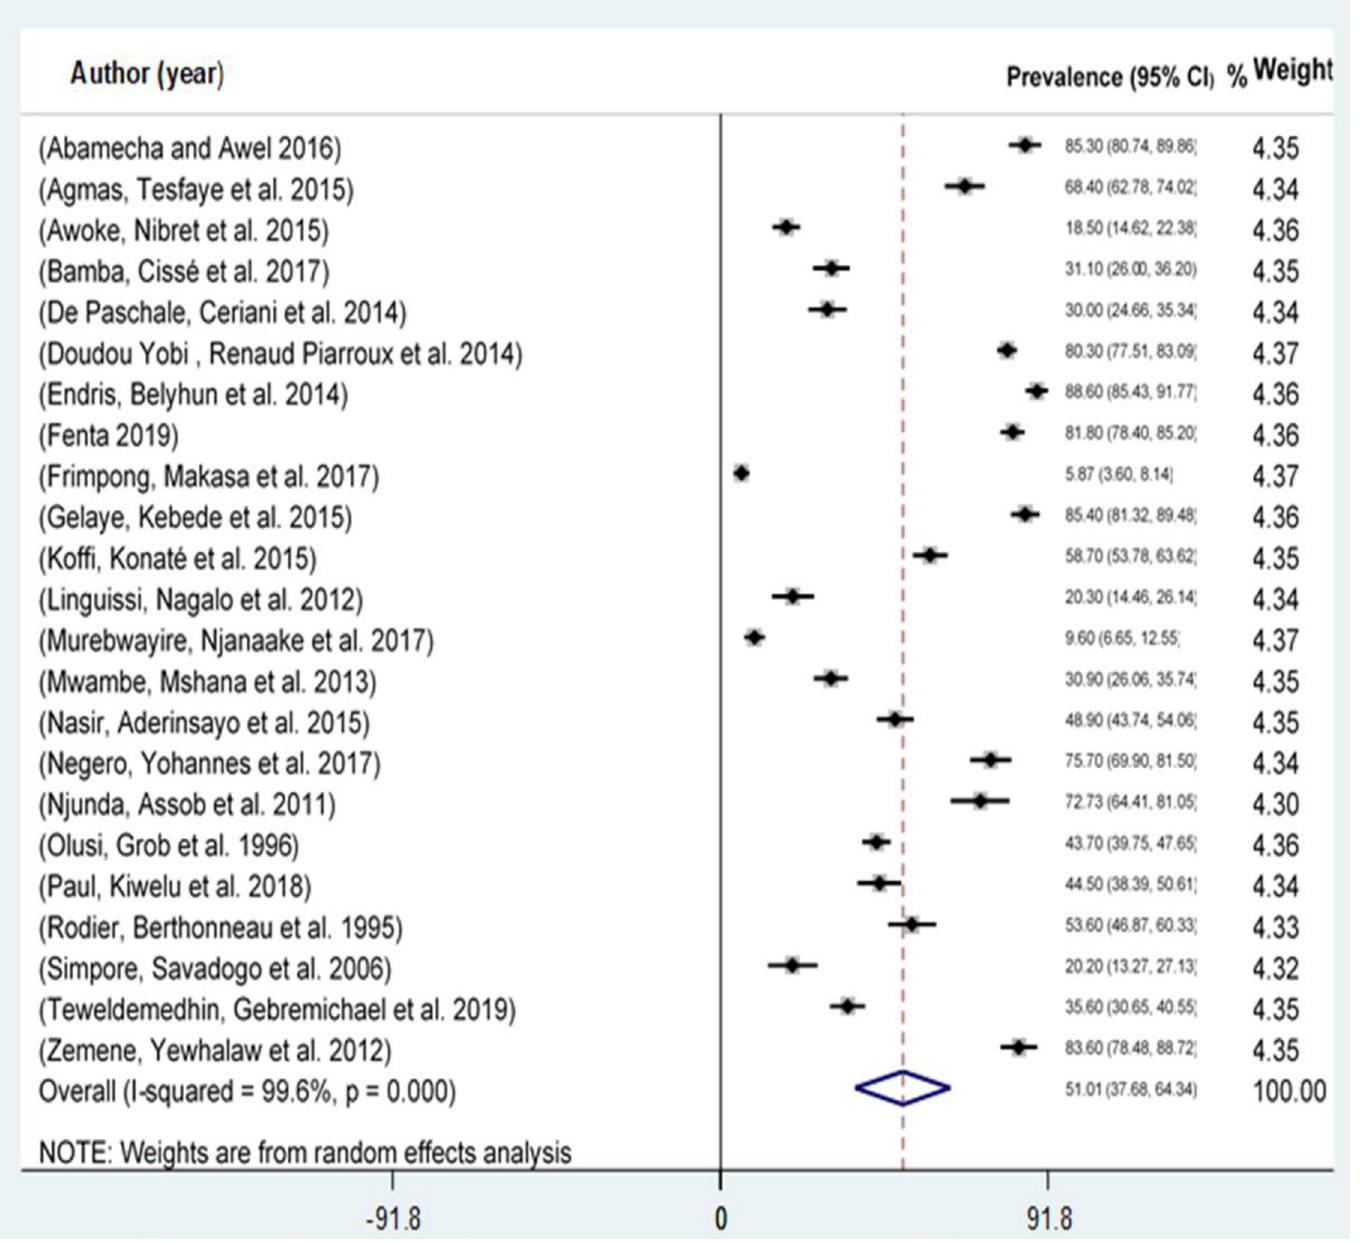
Fig 2. Pooled prevalence of toxoplasmosis among pregnant women in